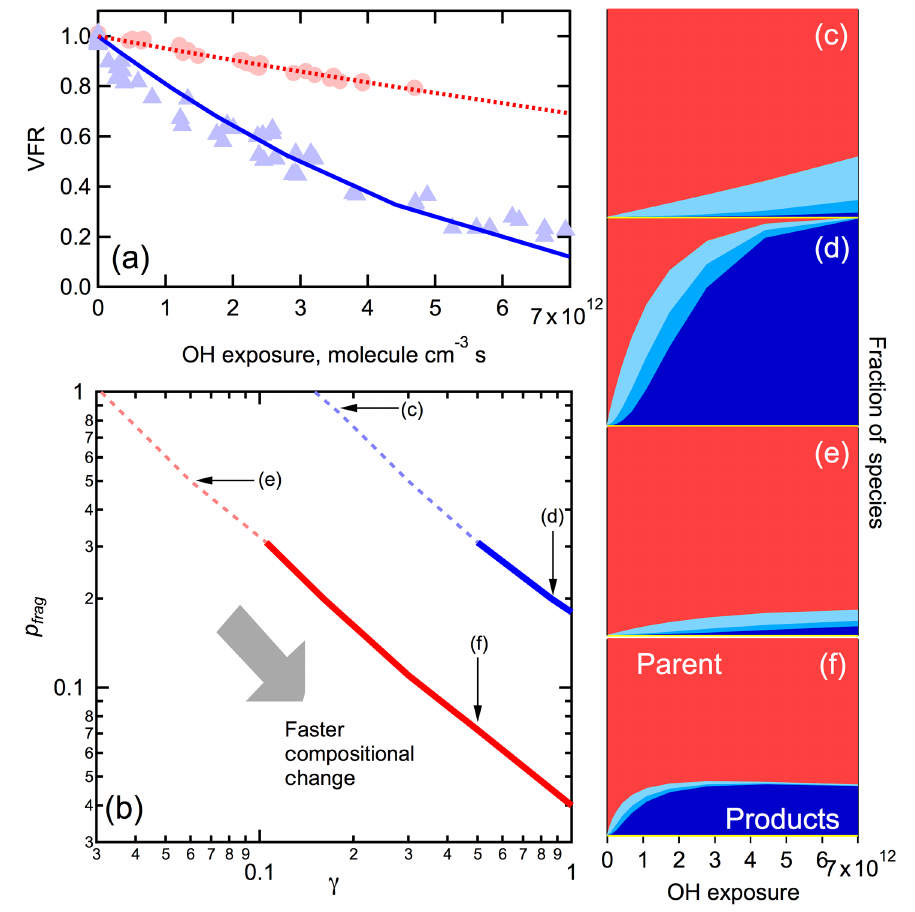
Figure 11. (a) Observed (points) and modeled (lines) VFR versus OH exposure for the best-fit models for both low-RH (red) and high-RH (blue) conditions. (b) Illustration of the relationship between γ and p frag that allow for a good fit to the observed VFR decay for low-RH (red) and high-RH (blue) conditions. The dashed lines show the full relationship, and the solid lines the best-estimate range. Four specific combinations of γ and p frag are indicated for consideration of the associated composition change. (c–f) Simulated normalized composition change as a function of OH exposure for the γ and p frag combinations indicated in panel (b) . The colors correspond to different species, with red indicating precursor (parent) species and other colors indicating various oxidation products (cf. Fig. 10). Greater compositional changes for a given OH exposure result from combinations with larger γ and smaller p frag for a given RH